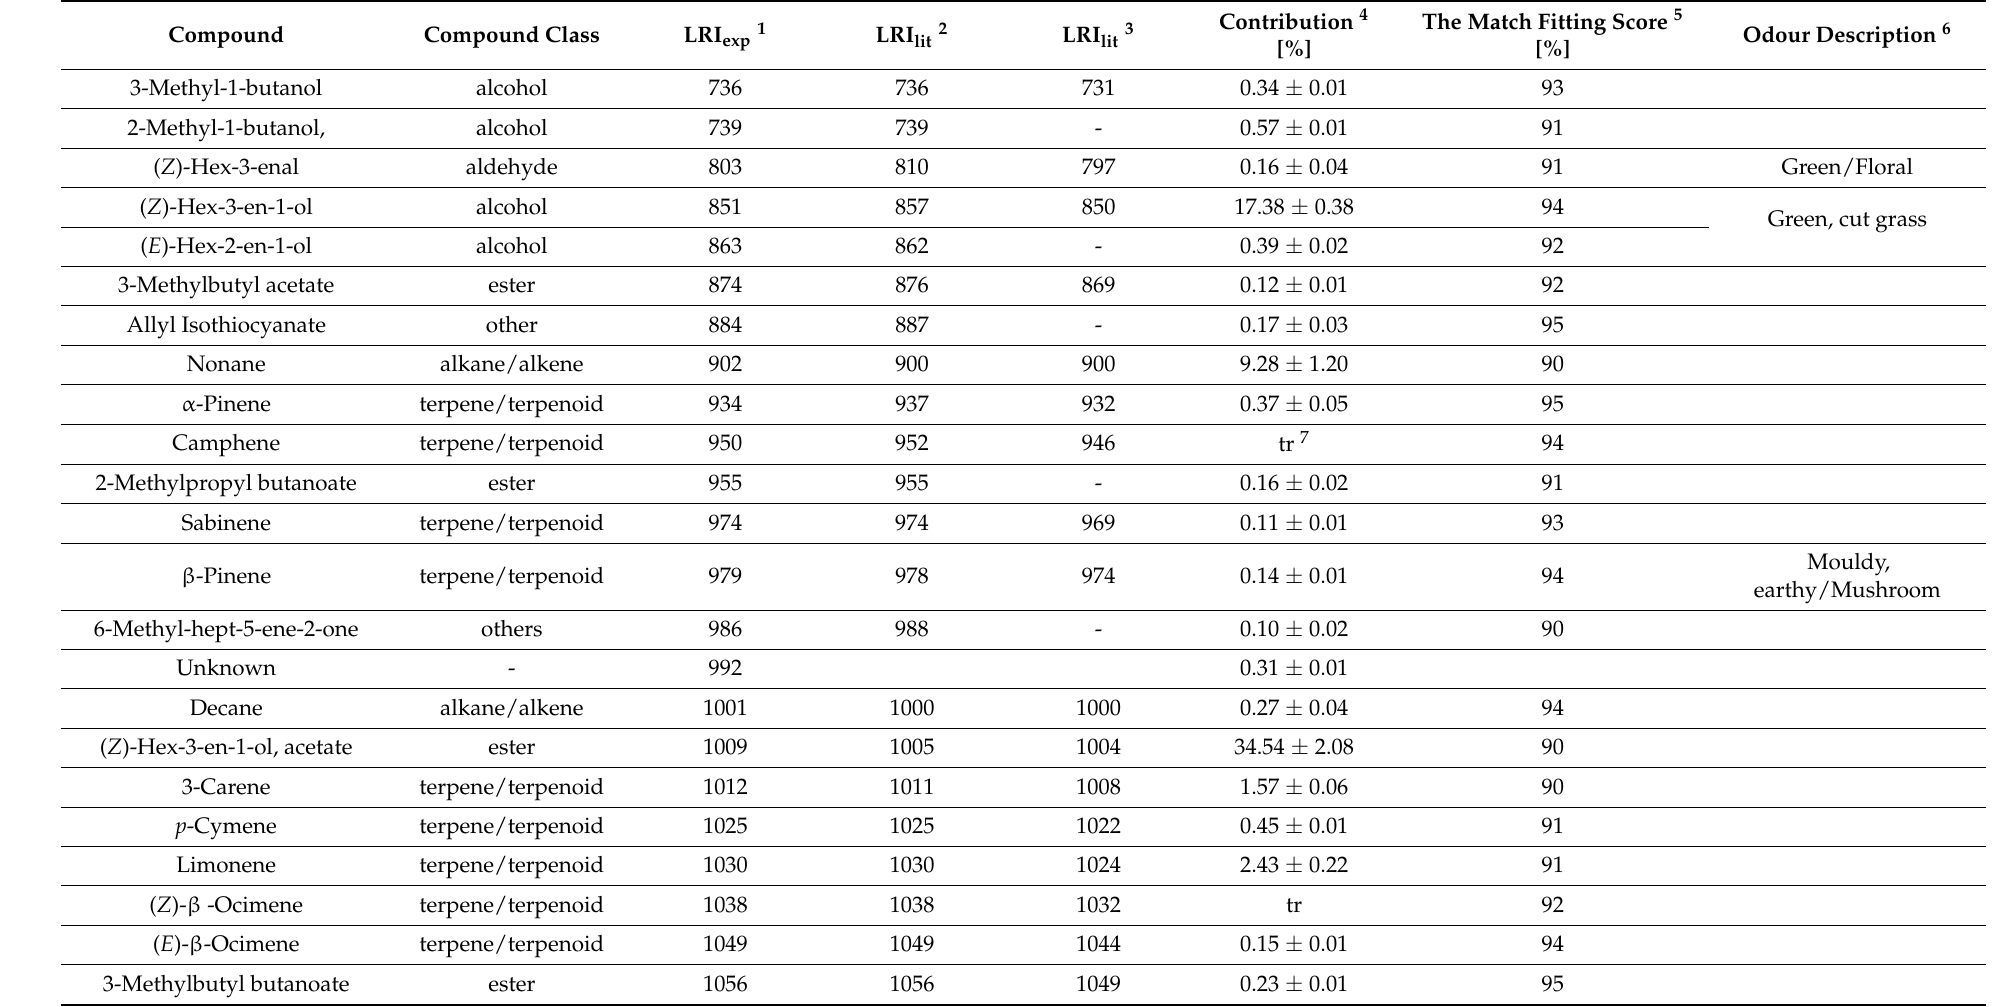
Table 3. Volatile organic constituent composition in fresh cilantro aroma